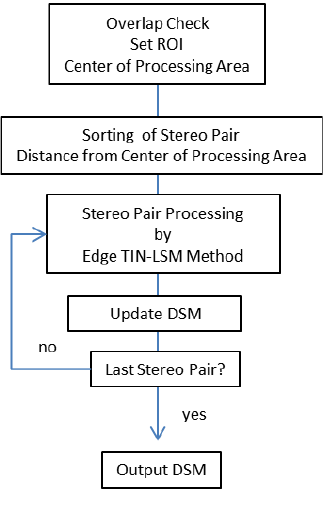
Figure 6. Processing Flow of Reconstruction of DSM